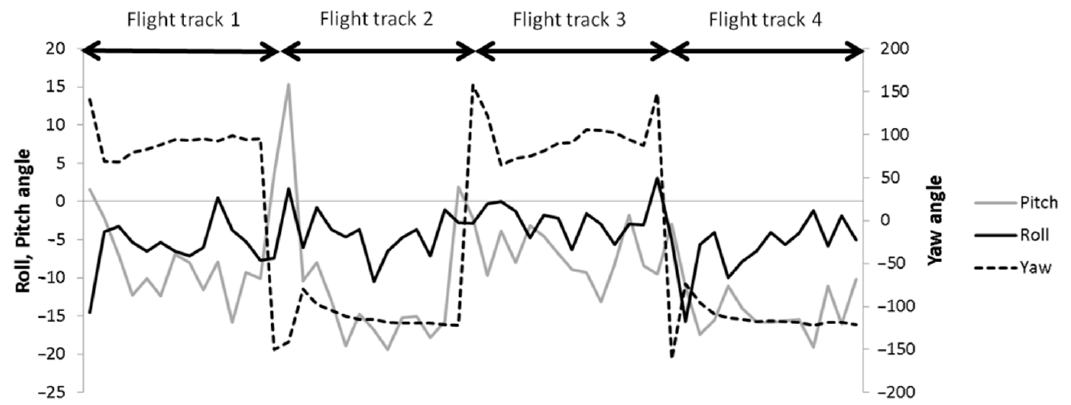
Figure 9. Roll, pitch, and yaw for the sunshine sensor during the flight at Lönnstorp on 22 September 2020.